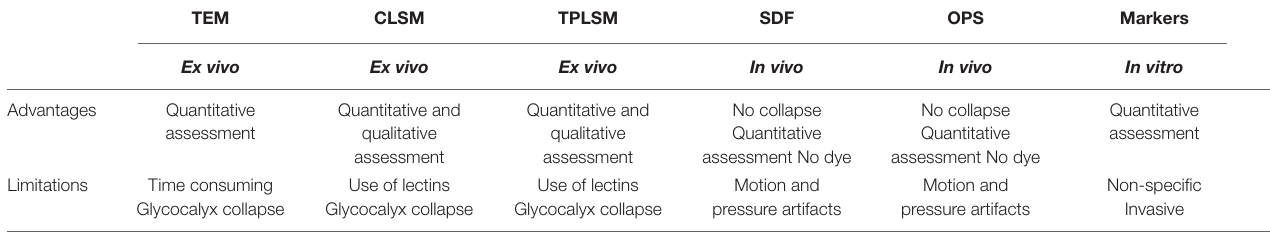
TABLE 1 | Summary of the pros and cons of different methods for assessing the glycocalyx.